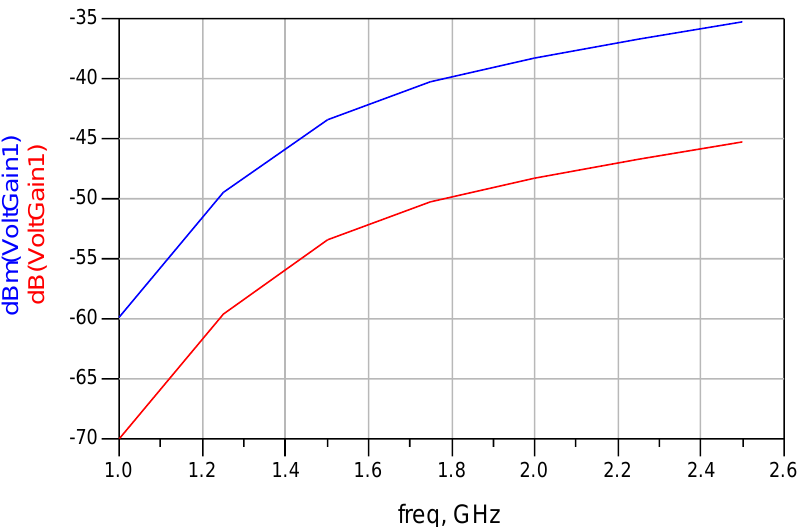
Figure 7. Voltage VSWR chart in parameter S.